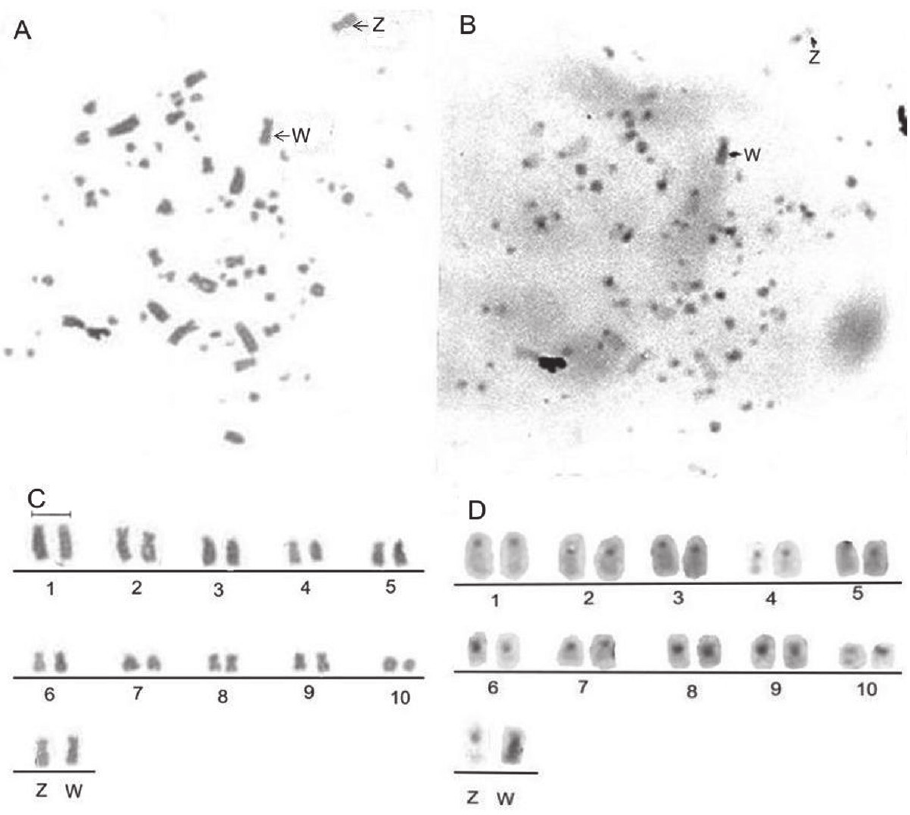
Figures 2 A–D. Metaphases and partial karyotype of female Nyctibius griseus : Giemsa ( A, C ) and C- banding ( B, D ) sequential staining. The arrows indicate the Z and W heterochromosomes. Among the autosomes, pairs 8 and 9 reveal an entirely heterochromatic short arm. Bar = 5